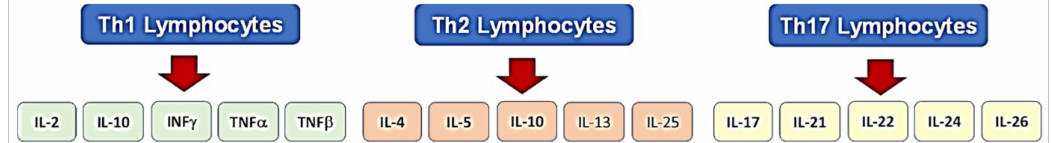
Figure 1. Th cells (Th1, Th2 and Th17) are the primary sources for the inflammatory